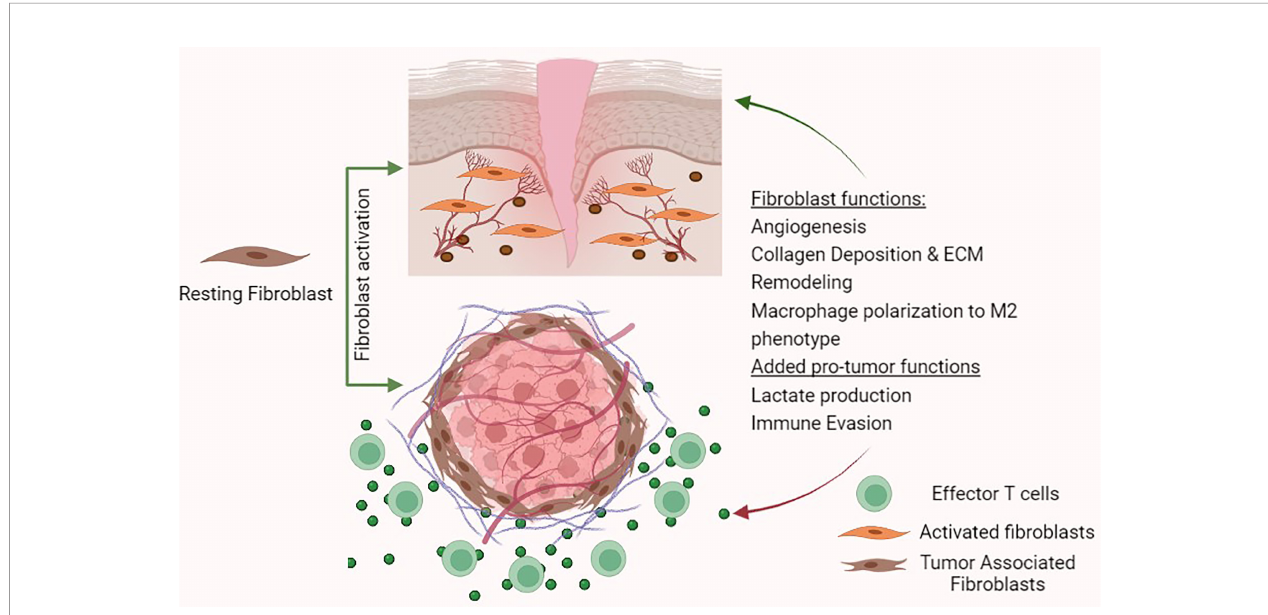
FIGURE 2 | Fibroblast functions in wound healing and tumour- promoting functions in the tumour